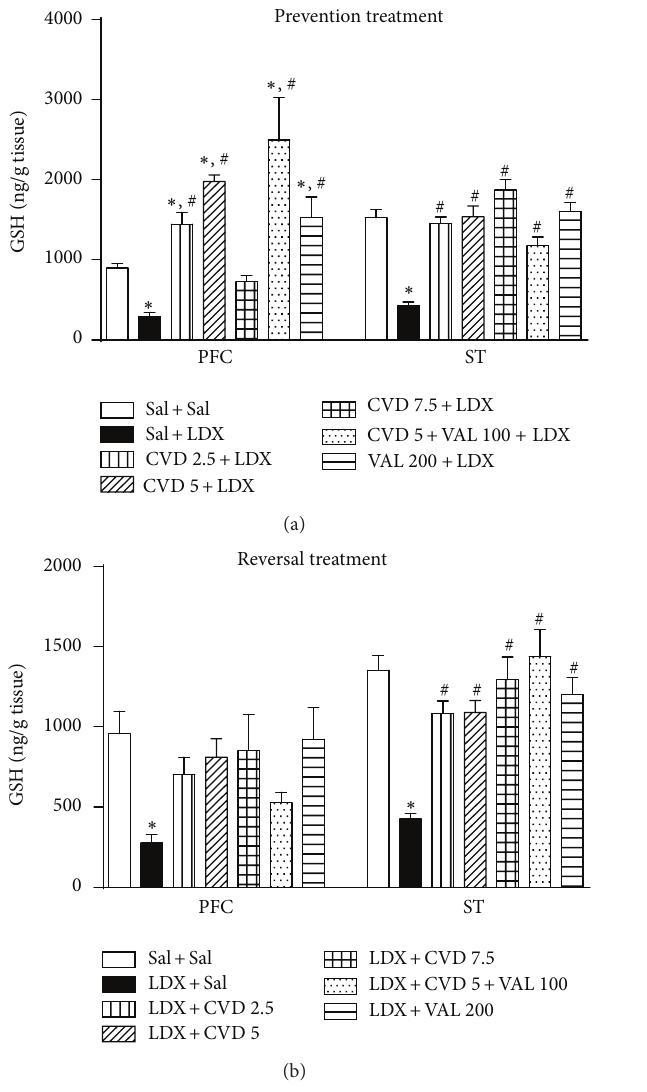
Figure 5: Levels of malondialdehyde (MDA), a lipid peroxidation marker, in the prefrontal cortex (PFC) and striatum (ST) of mice submitted to the prevention (a) and reversal (b) treatments. Data were analyzed by one-way ANOVA followed by Student-Newman- Keuls post hoc test. Values are expressed as mean ± SEM (6–8 animals/group). ∗ 𝑃 < 0.05 versus Sal + Sal; # 𝑃 < 0.05 versus Sal + LDX or LDX + LDX. CVD: carvedilol; LDX: lisdexamfetamine; Sal: saline; VAL: